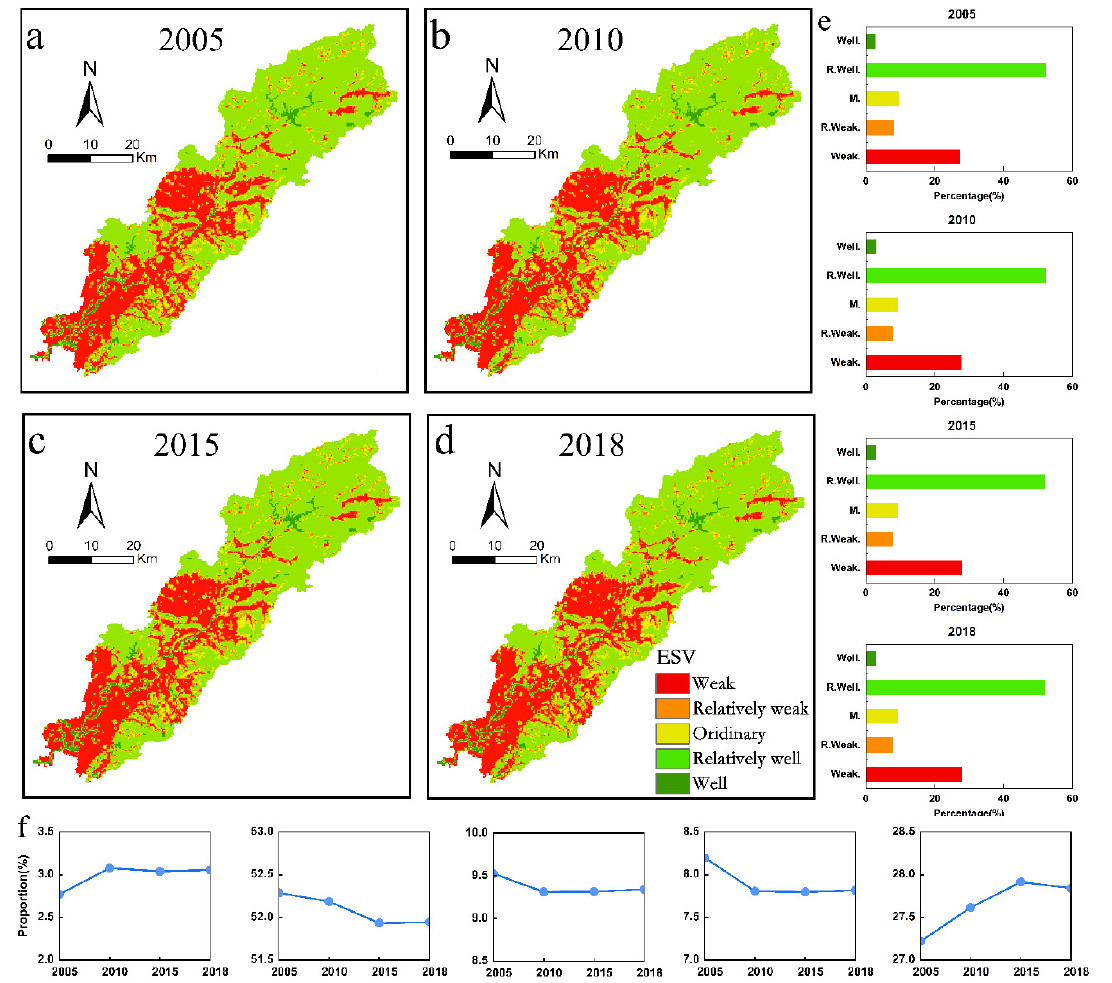
Figure 4. Spatial distribution of ESV in ( a ) 2005, ( b ) 2010, ( c ) 2015, and ( d ) 2018; ( e ) the percentage of areas with different levels in each year; and ( f ) the percentage of all grids in each ESV level. ESV, Ecosystem service